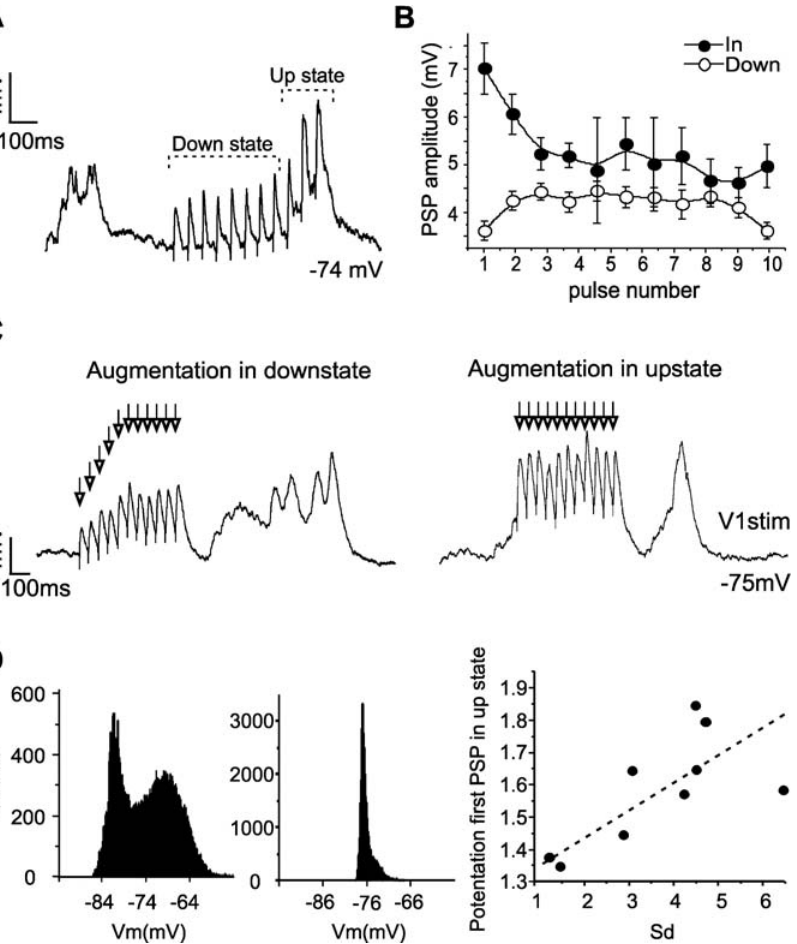
Figure 9. Synaptic enhancement with trains of electrical stimuli. A. Intracortical synaptic potentials activated by a 20 Hz train of electrical stimulation in vivo . The first 8 PSPs occurred during the down state and the following ones coincided with an up state. Note that the ones during the down state display synaptic facilitation, but their amplitude increased even further when occurring during the up state. B. Averaged PSPs amplitudes occurring during up ( In ) and down ( Down ) states for the same neuron as in A. Each point represents an average of 8–16 PSPs. Error bars are s.e.m. C. Repetitive electrical activation of intracortical synaptic potentials in vivo during down states (left) and during an up state (right). D. Distributions of the membrane potential values measured in a time window of 60 s and with a sampling rate of 10 KHz in a neuron during high spontaneous activity (left panel; s.d. 6.28) and another neuron with less spontaneous activity (middle panel; s.d. 1.62). Correlation between the standard deviation of the membrane distribution and the amplitude increase of the first PSP in the pair (n=9 neurons; right panel).